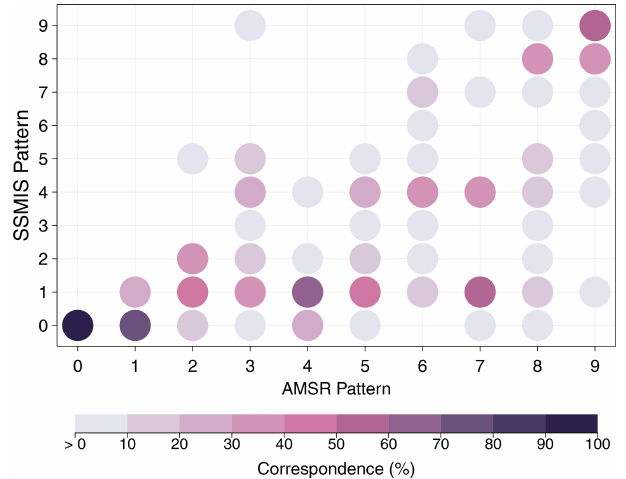
Figure 8. Correspondence of the daily spatial melt distribution for the AMSR and SSMIS sensors. Observations from both sensors are mapped against the nine melt patterns (Fig. 2). Colours indicate the percentage of days on which the pattern assigned to the AMSR data matches the pattern assigned to the SSMIS data. Pattern 0 indicates days that are outside of the melt season as defined by the respective sensor and are thus not assigned a SOM